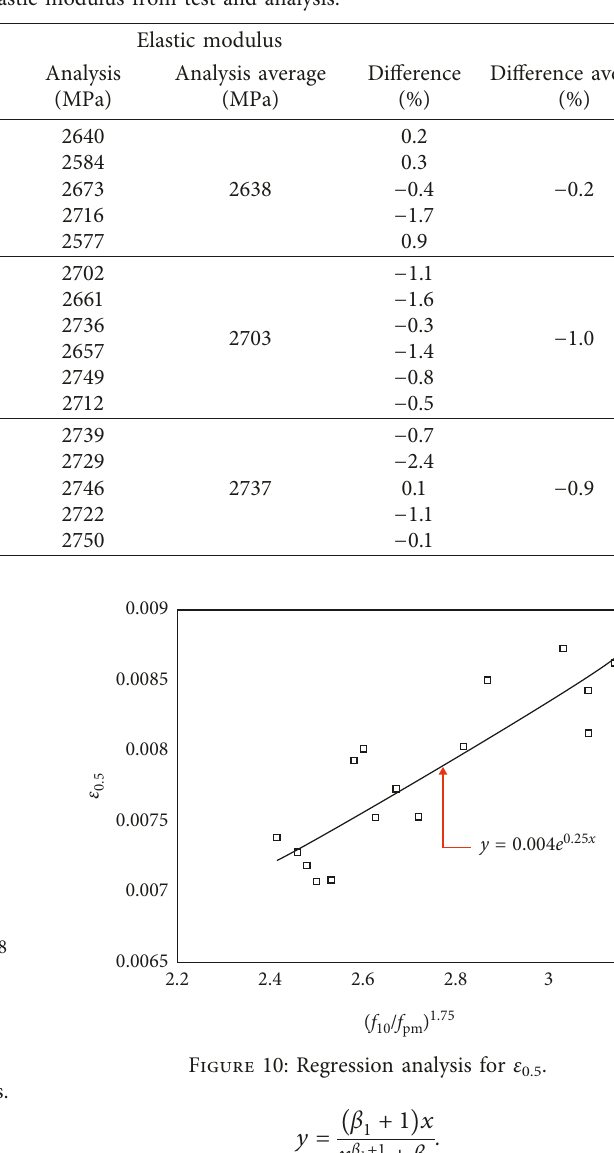
Table 4: Comparison of elastic modulus from test and analysis.